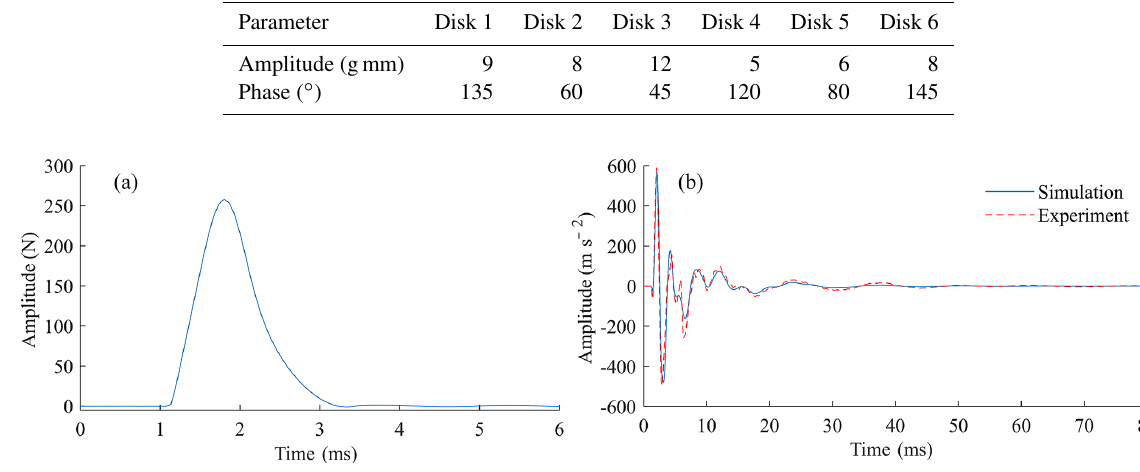
Table 2. Virtual initial unbalance.